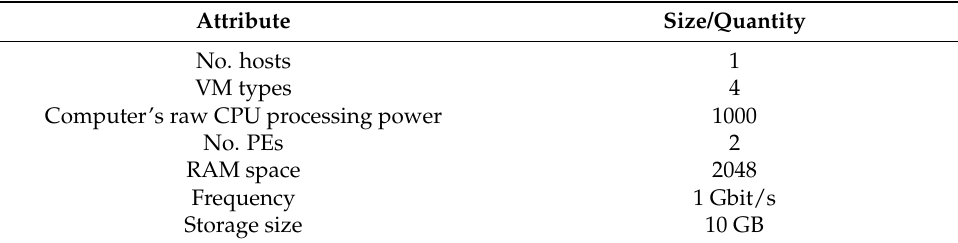
Table 2. Physical Machine